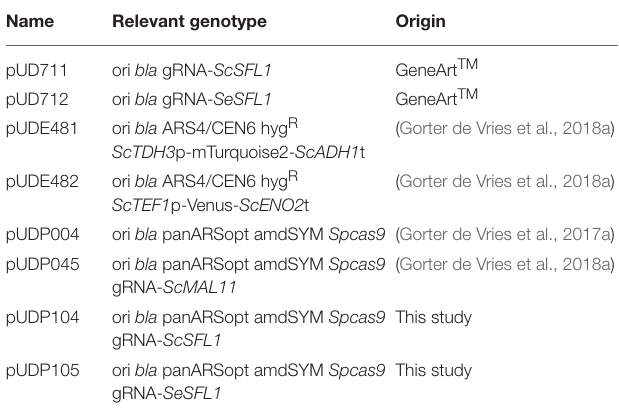
TABLE 1 | Plasmids used throughout this